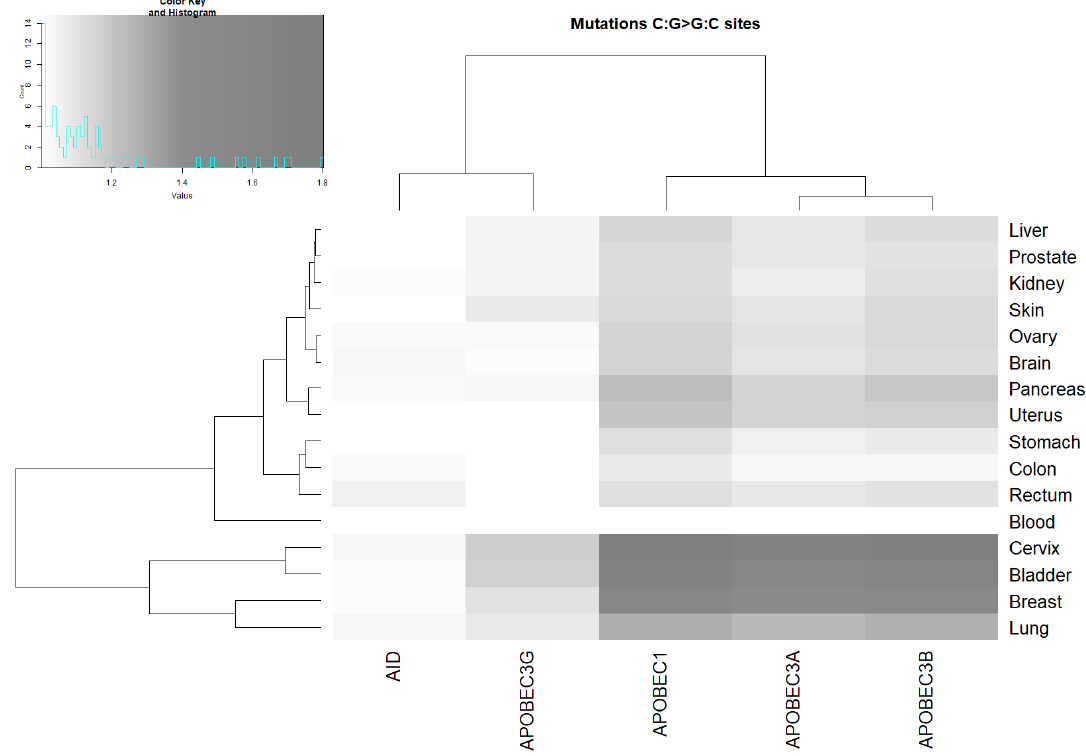
Figure 3. Correlation between AID/APOBEC mutable motifs and the sequence context of somatic C:G>G:C mutations. For actual data, see Supplementary Table S7. The intensities of the gray color correspond to the ratio values (the ratio being the mean weight of the mutated sites divided by the mean weight of the non-mutated sites).